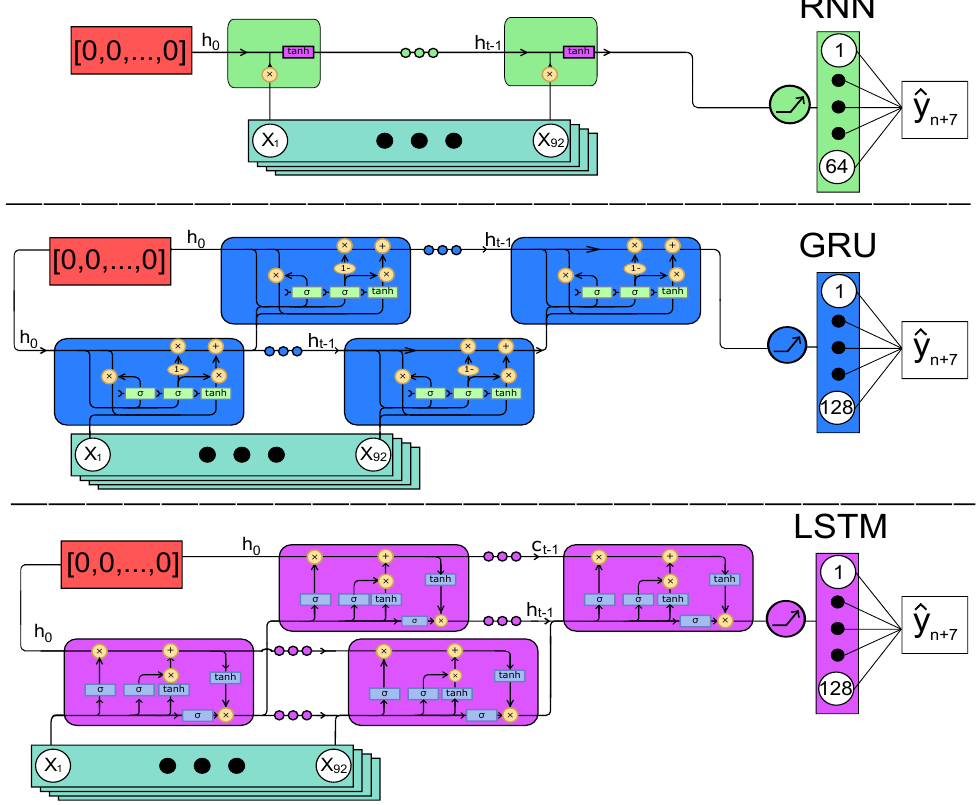
Figure 2. Architecture for each of the three models. Models were initialized with a zero vector (red region) and provided a series of 92 days of financial data. Nonlinearity was introduced in each model using the ReLU function prior to the fully connected layer where the dropout was applied to the LSTM and GRU. The Dropout was applied to the 8, 46, 61, 67, 83, 92, and 123rd values in the fully connected layer. The same dropout was applied to the GRU with the addition of the 64 and 125th